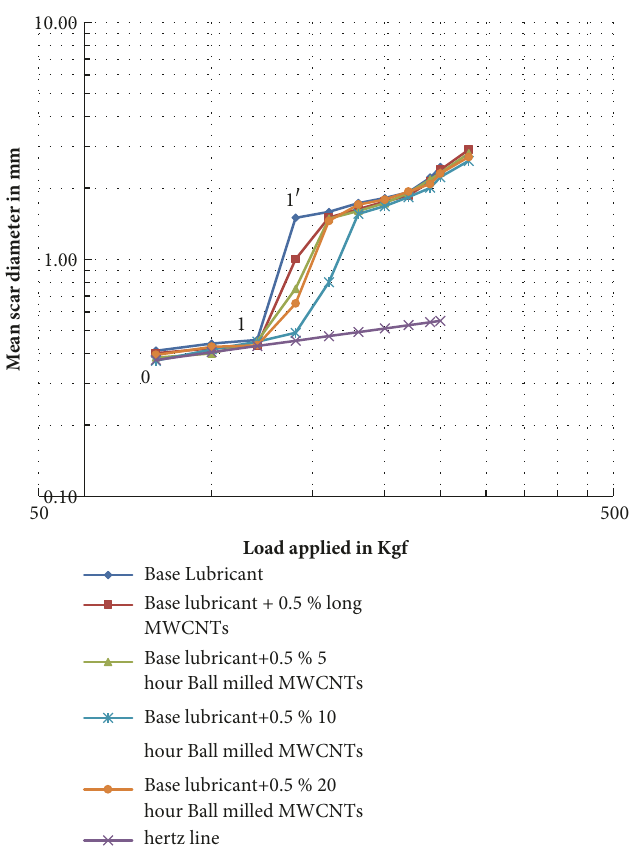
Figure 10: Variation of wear scar diameter with applied load during EP